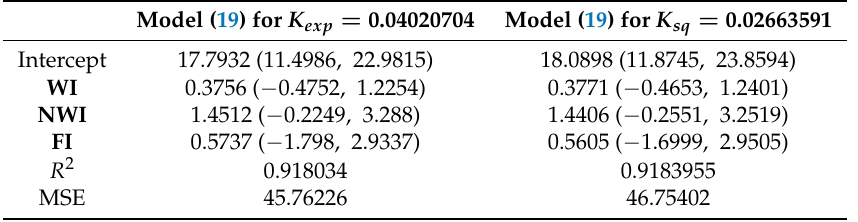
Table 12. Estimation of the ridge models for K exp = 0.04020704 and K sq = 0.02663591. Confidence interval, at 10% confidence, is obtained from bootstrap inside the parentheses, and R 2 is the coefficient of determination obtained from Rodríguez et al.